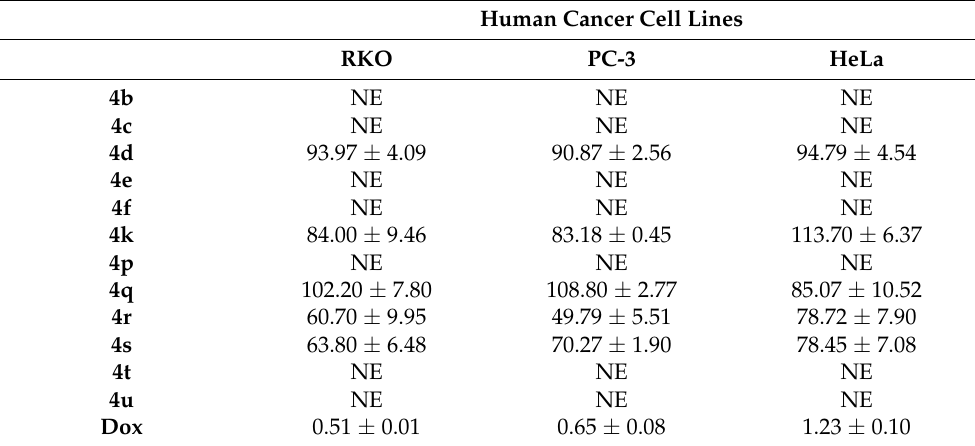
Table 2. Inhibitory activity of bis(spiropyrazolone)cyclopropanes 4 against human cancer cell lines, reported as IC 50 ( µ